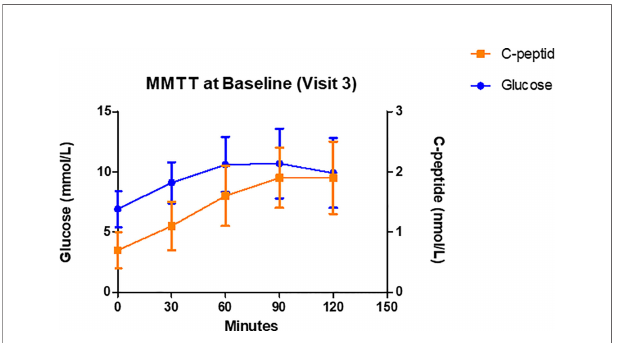
TABLE 3 | Characteristics of the study population.